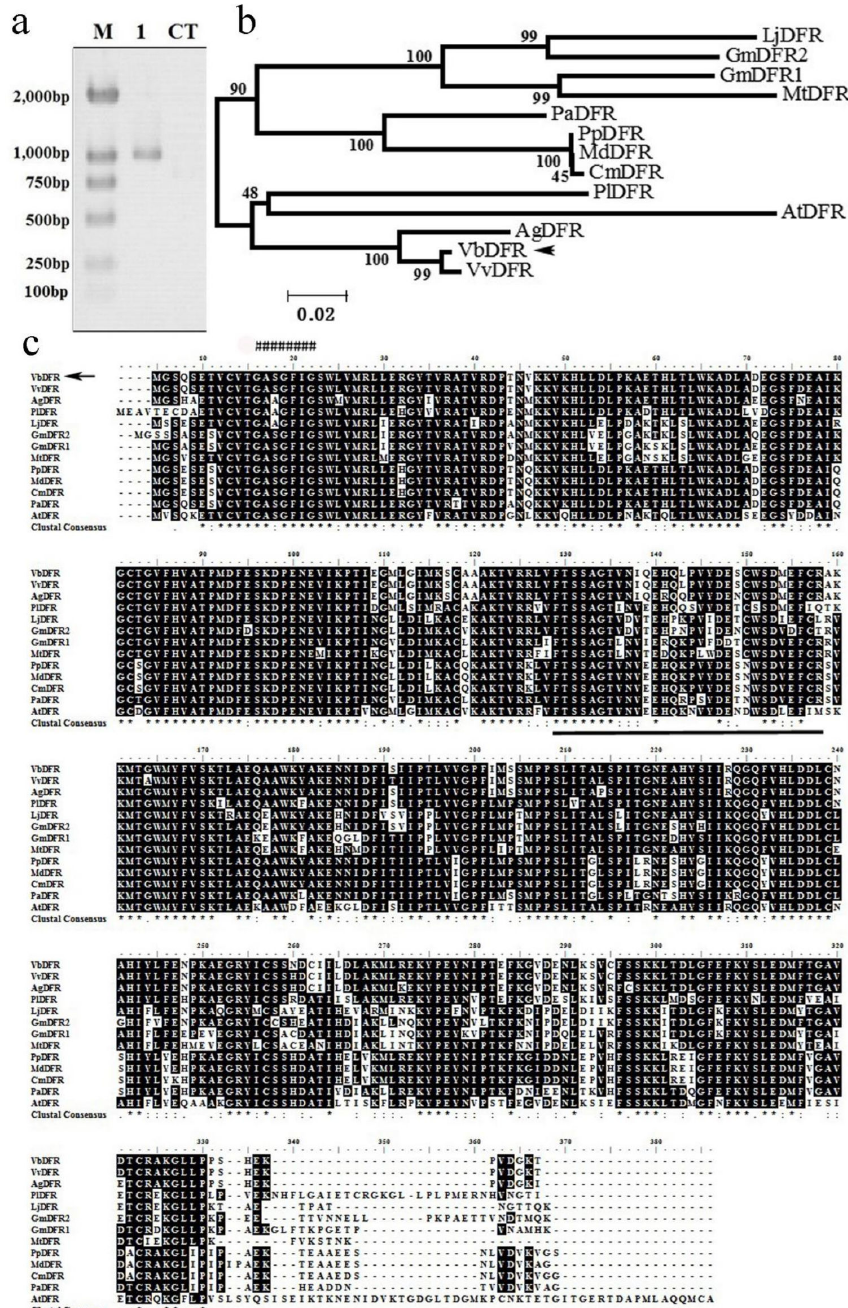
Figure 2. Cloning, amino acid sequence alignment, and an unrooted phylogenetic tree of DFR obtained from deduced amino acid sequences of 13 DFR homologs. ( a ) a DFR cDNA fragment was amplified from V. bellula leaf tissue by RT-PCR. M: DNA marker, 1: DFR cDNA fragment, CT: negative control; ( b ) an unrooted phylogenetic tree was built from amino acid sequences of 13 DFR homologs; ( c ) amino acid sequence alignment were develop from 13 DFR homologs; “*”: the same amino acid in all sequences; “:”: conserved amino acid residues; “.”: half conserved amino acid residues; “######”: potential NADPH/NADH binding domain; amino acids underlined form a potential substrate specificity domain of DFR. AtDFR: Arabidopsis thaliana DFR; CmDFR: Crataegus monogyna DFR; GmDFR1: Glycine max DFR1; GmDFR2: Glycine max DFR2; LjDFR: Lotus japonicas DFR; MdDFR: Malus domestica DFR; MtDFR: Medicago truncatula DFR; NgDFR: Nekemias grossedentata DFR; PaDFR: Prunus avium DFR; PpDFR: Pyrus pyrifolia DFR; PlDFR: Paeonia lactiflora DFR; VvDFR: Vitis vinifera